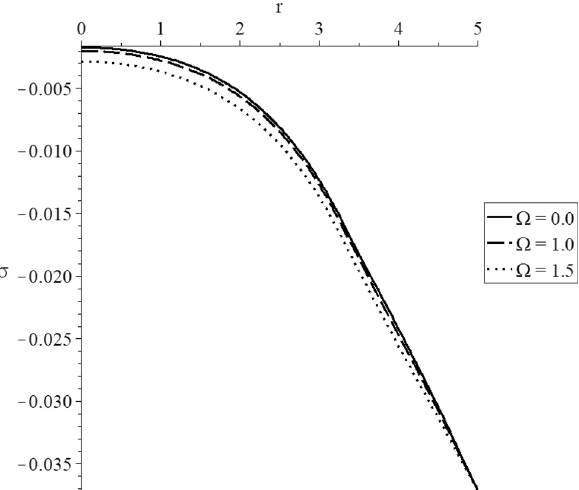
Figure 19. The average stress with various values of the angular velocity of the rotation parameter.